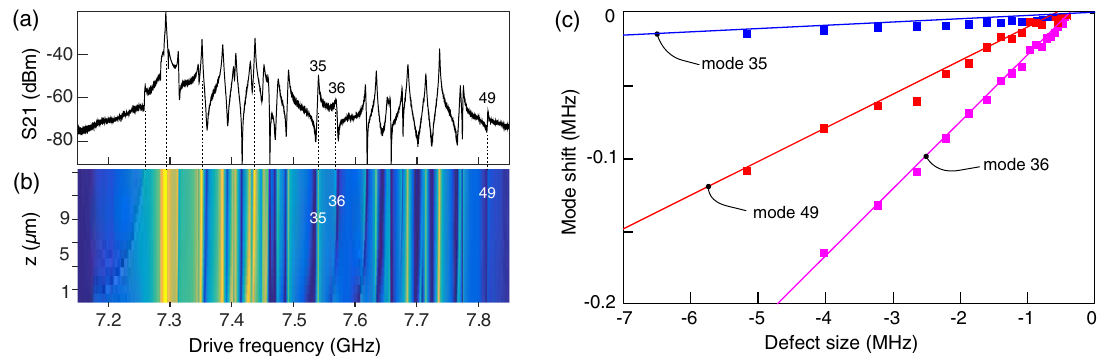
FIG. 4. Transmission and mode-shift data from scanning defect microscopy. (a) The transmission spectrum of the kagome lattice exhibits a multitude of resonances corresponding to normal modes that can be excited and detected through the selected input and output ports. (b) Positioning the scanning probe above one resonator and changing the vertical probe distance z produces shifts in mode frequencies, here seen as “ bending ” of maxima in the measured transmission S21 (color-coded), especially for small probe distances. (c) Calibration allows conversion of the probe height z into the corresponding defect size Δ ω n of site n . For small defect size, the normal-mode shifts ΔΩ μ j n are linear in the Δ ω n . Normal-mode weights are directly determined from the slope of each